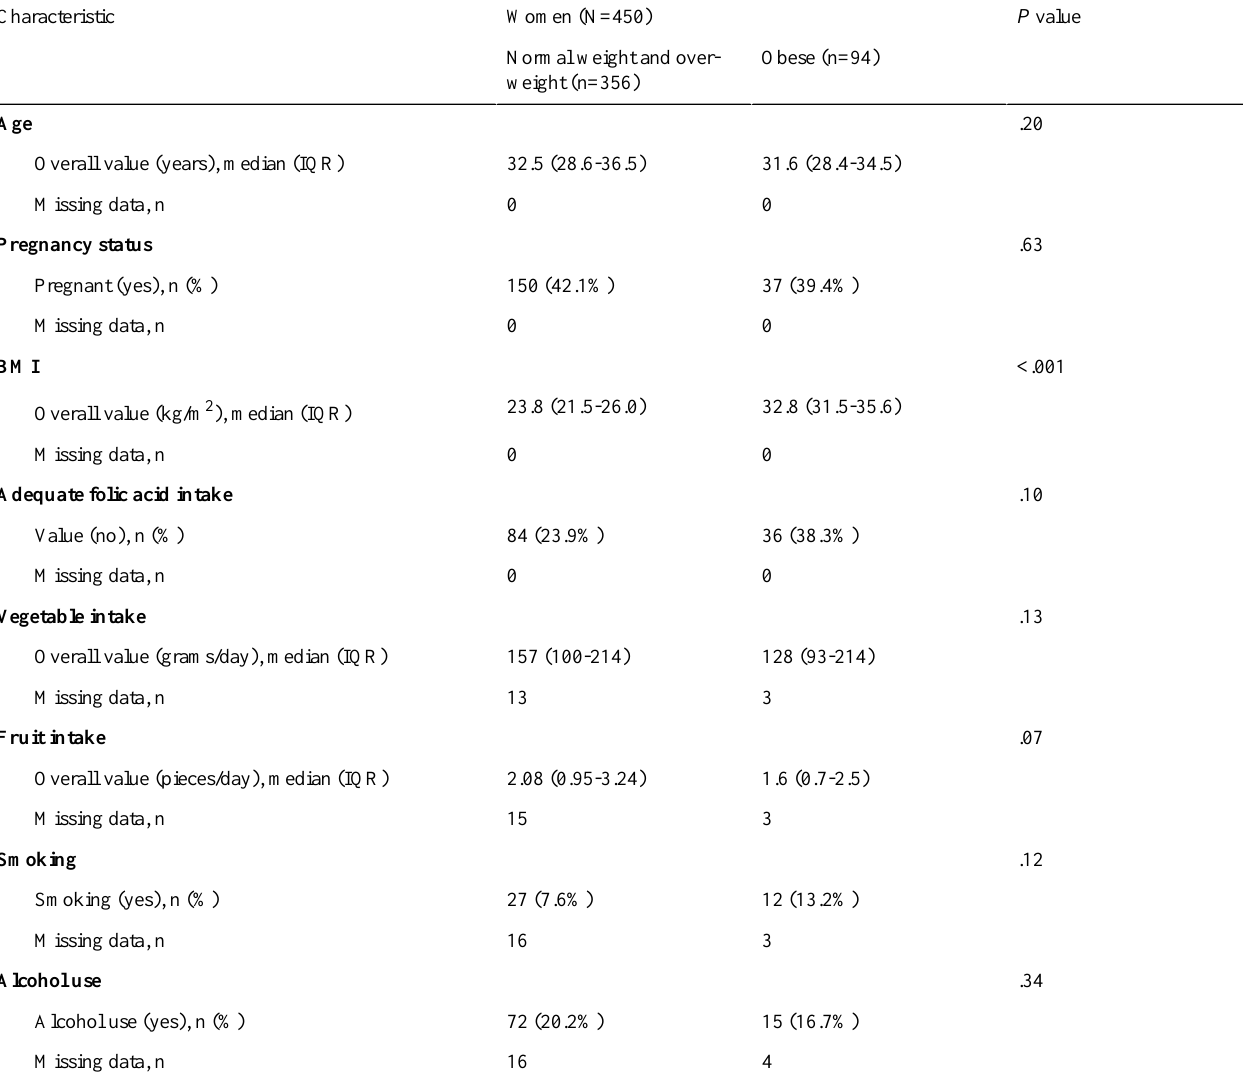
Table 2. Differences in lifestyle behaviors at baseline between normal weight and overweight women and obese women.